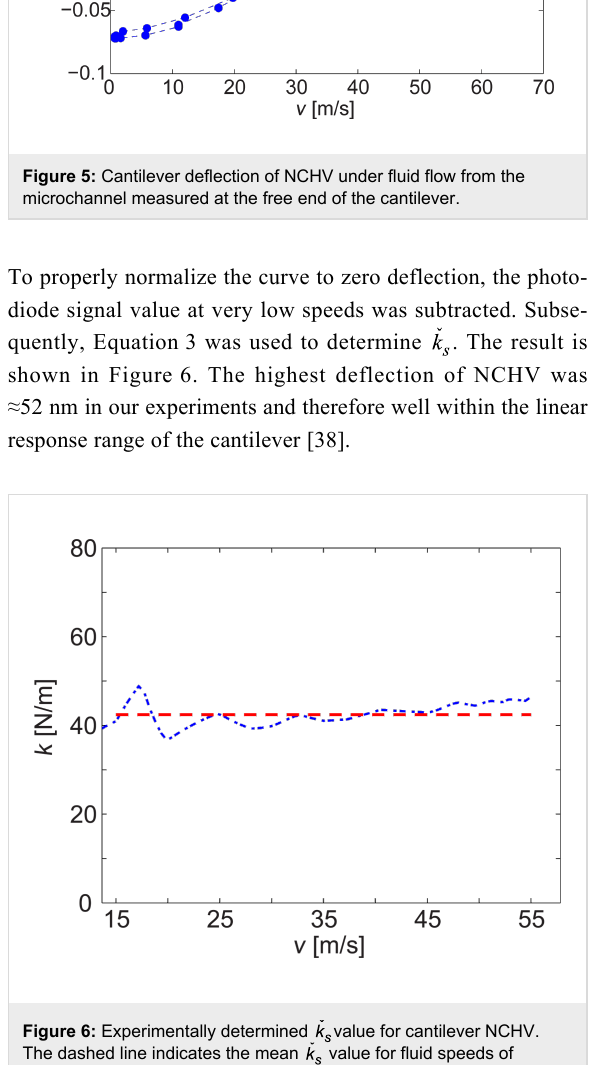
Figure 6: Experimentally determined value for cantilever NCHV. The dashed line indicates the mean value for fluid speeds of 15–55